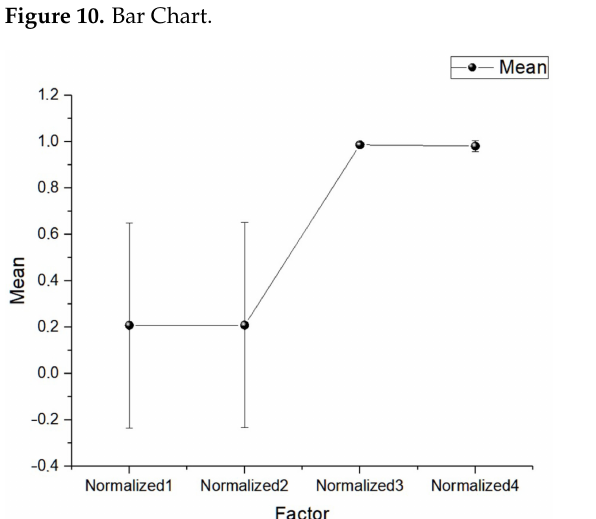
Figure 10. Bar Chart.